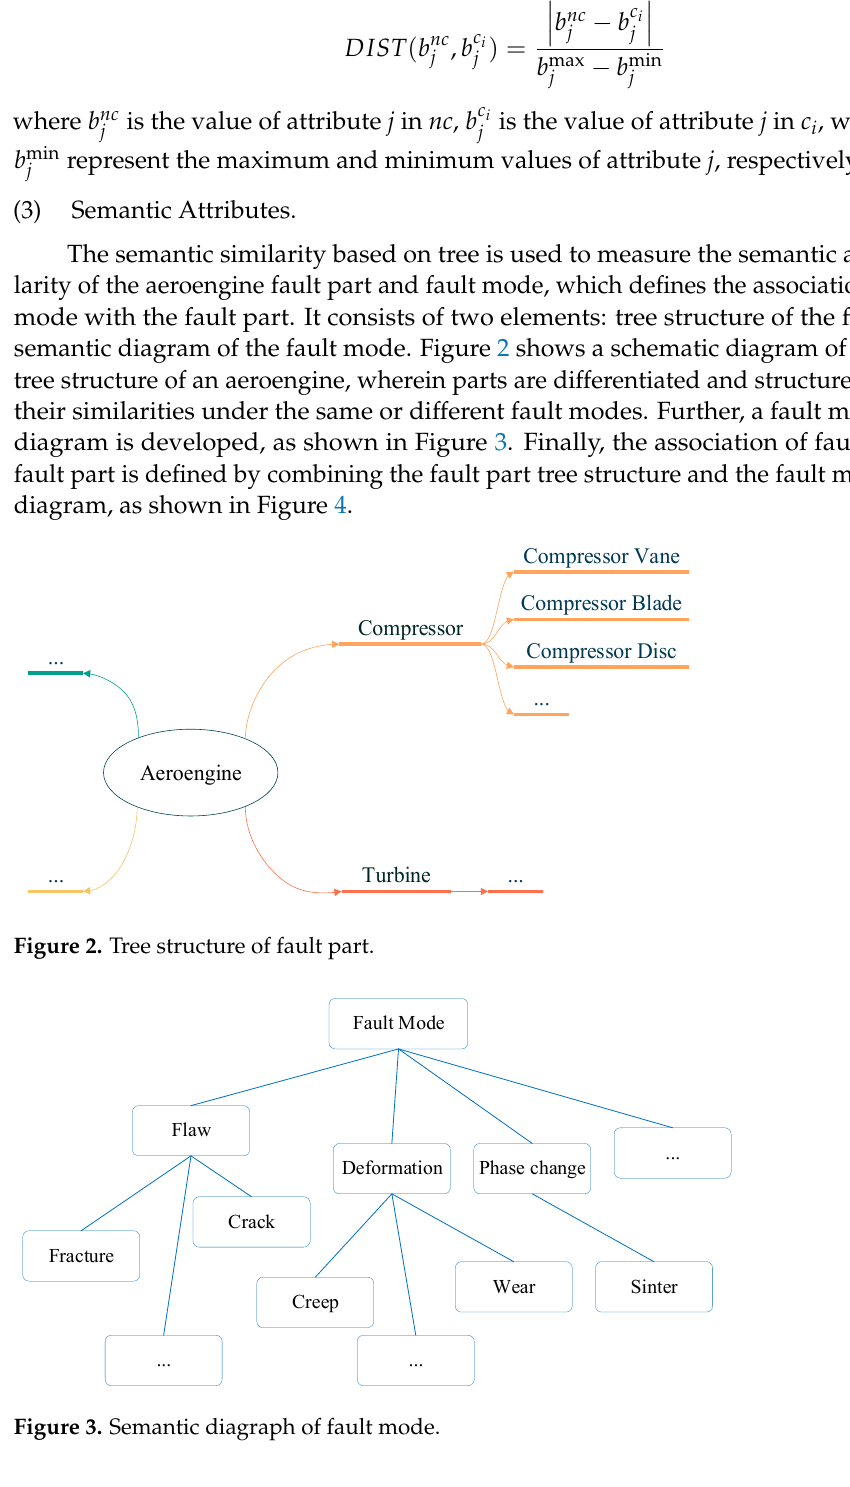
Figure 4. Aeroengine fault semantic graph. The measure of semantic similarity is based on the following three constructs. (i) In the semantic graph, two nodes with shorter distance are more similar than two nodes with longer distance. The shortest path between nodes n i and n j is denoted as Dist ( n i , n j ). For example, Dist (“ Fracture (Compressor Blade )”, “ Wear ( Compressor Blade )”) = 4 implies that the shortest path between Fracture (Compressor Blade ) and Wear ( Compressor Blade ) is 4. (ii) The nearest shared parent node n k of nodes n i and n j is represented by Nspn ( n i , n j ). For example, Nspn (“ Crack (Compressor Vane ),” “ Crack ( Compressor Blade )”) = Compres- sor , which means compressor is the nearest shared parent node of Crack (Compressor Vane ) and Crack ( Compressor Blade ). (iii) The distance from a node to the root node is defined as the depth of the node, denoted as Depth ( n k ). For example, Depth ( Compressor Vane ) = 2 indicates that the depth of node Compressor Vane from root node Aeroengine is 2. Then, the semantic similarity is defined as a function of the node location in the tax- onomy, which is calculated using Equation (6). 2